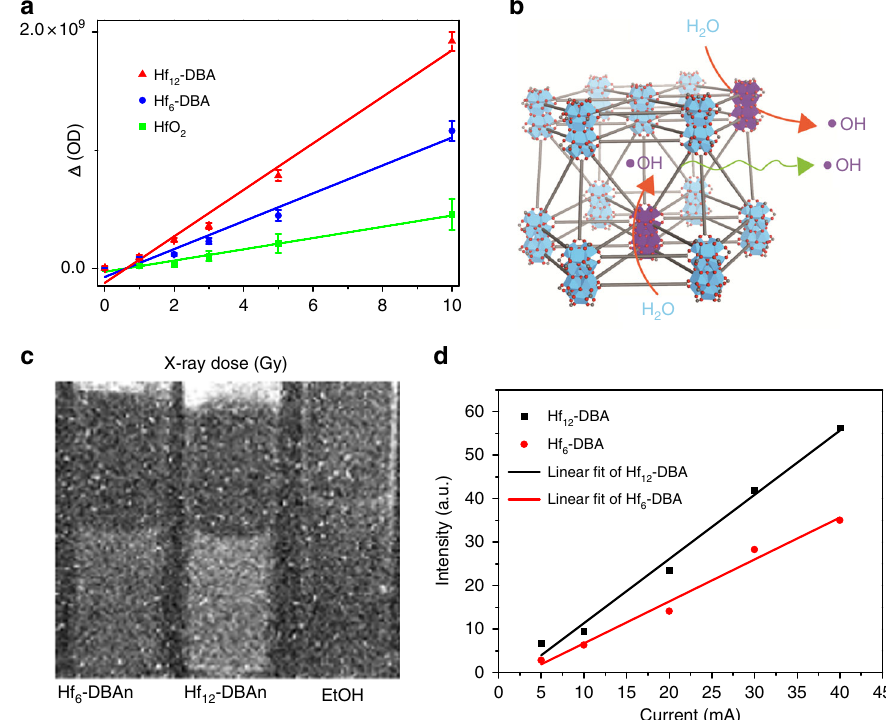
Fig. 2 Radioenhancing ef fi ciency of HfO 2 vs. Hf 6 -based and Hf 12 -based nMOFs. a Enhanced APF fl uorescence of HfO 2 , Hf 6 -DBA, and Hf 12 -DBA over H 2 O at equivalent Hf concentrations of 20 μ M. n = 6. b Illustration of ef fi cient hydroxyl radical generation upon X-ray irradiation and diffusion through porous Hf 12 - DBA nanoplates. c Optical images of radioluminescence from Hf 6 -DBAn (1 mM in ethanol), Hf 12 -DBAn (1 mM in ethanol), and pure ethanol at an X-ray dose rate of 2.93 Gy/min. d Linear fi ts of radioluminescence intensities with respect to X-ray tube currents of Hf 6 -DBA and Hf 12 -DBA after subtraction of pure ethanol background. Central data points and error bars represent mean ± s.d. values, respectively. Hydroxyl detection result was obtained without repetition. The radioluminescence images were obtained with two repetitions to afford similar